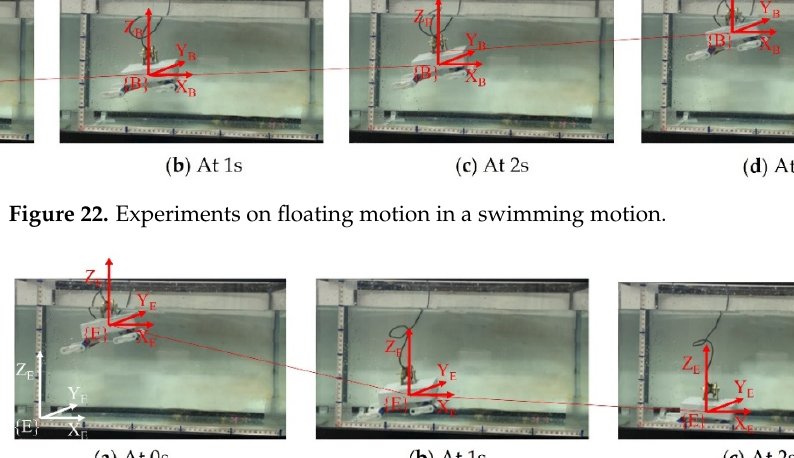
18 of 22 Figure 20. Experiments on forwarding motion in a swimming motion. Figure 21. Experiments on turning left motion in a swimming motion. For the dive and float motion, two propeller thrusters will work together. To make the son underwater dive and float underwater stability, the relationship between buoy- ancy and gravity was considered at the beginning of the design, as introduced in Section 2. At the same time, they ensured that the robot floated underwater; the CG and the BG were at the same point. The center of the robot body was set as the reference point for recording the experimental data. The son underwater robot dive and float motion exper-